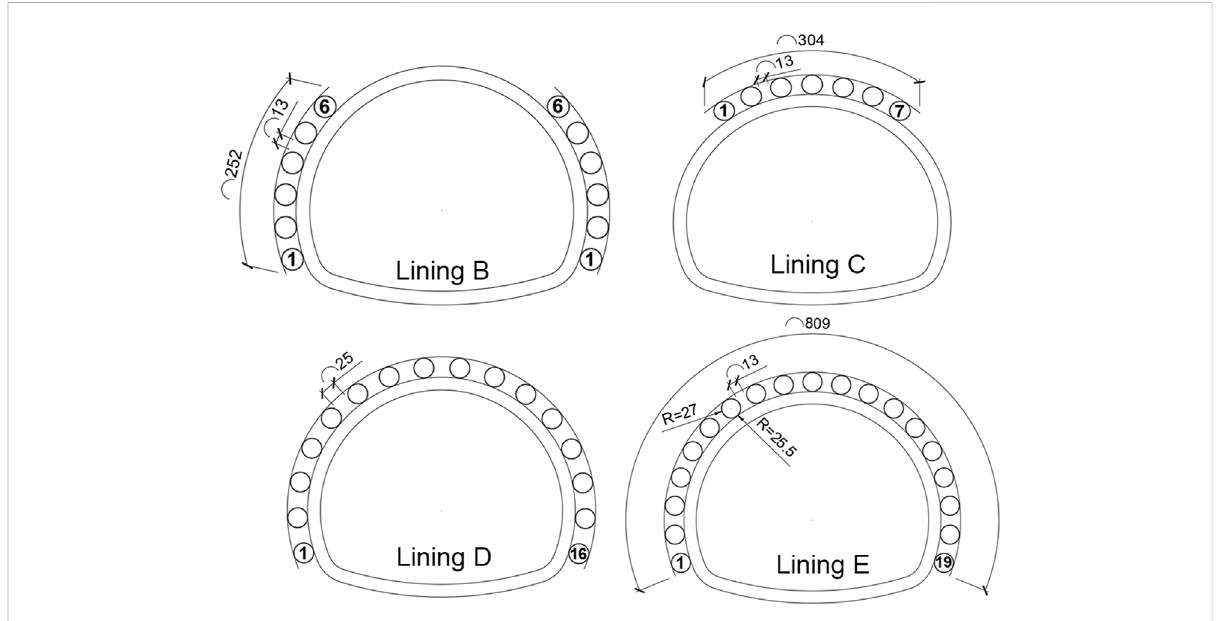
FIGURE 6 Schematic diagram of the limiting resistor